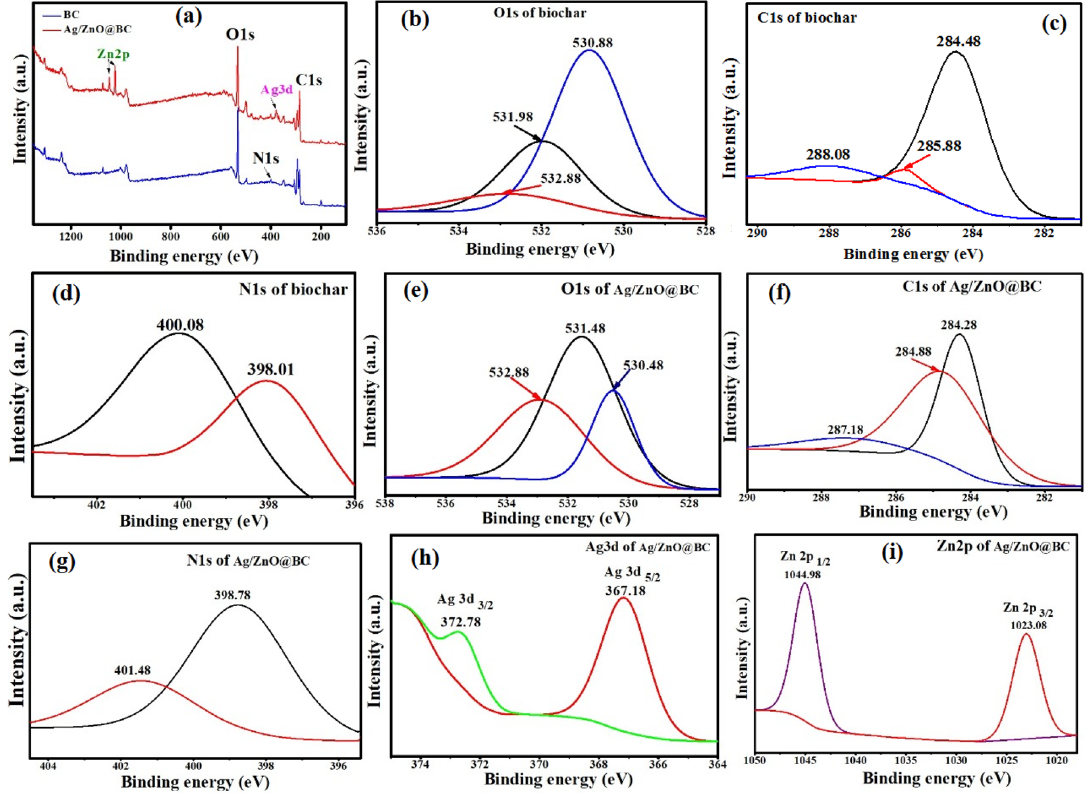
Figure 7. XPS spectra for biochar and Ag/ZnO@BC survey ( a ), biochar O1s ( b ), C1s ( c ), N1s ( d ), Ag/ZnO@ BC O1s ( e ), C1s ( f ) N1s ( g ), Ag3d ( h ) and Zn2p ( i